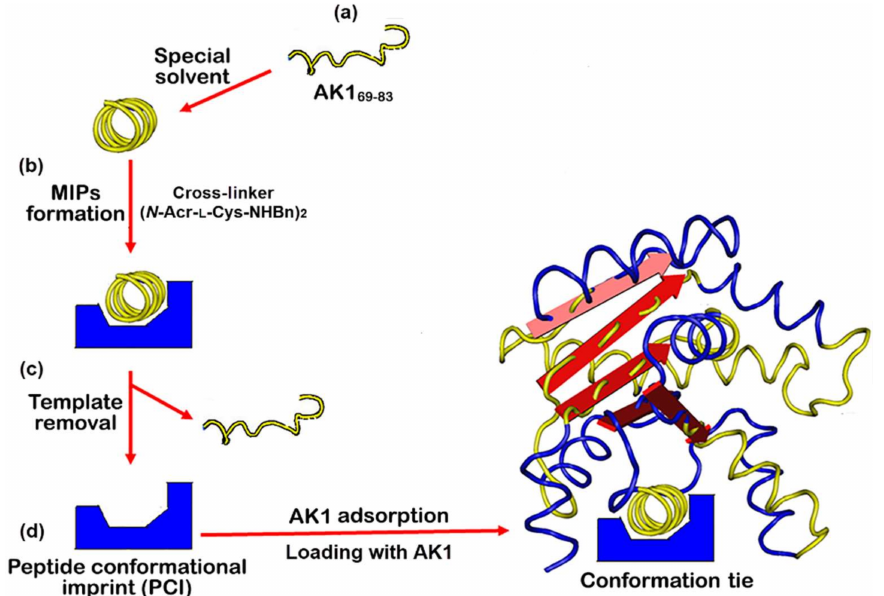
Figure 3. The fabrication of a peptide conformational imprint for adenylate kinase 1 (AK1). ( a ) Prepa- ration of the AK1 69-83 as a template. ( b ) Fabrication of hinge-mediated molecularly imprinted polymers (MIPs) in a special solvent using cross-linker ( N -Acr-L-Cys-NHBn) 2 and the template. ( c ) After template removal, the peptide conformational imprint (PCI) was complementary to the tem- plate peptide. ( d ) PCI loading with AK1. The recognition of an AK1 and its characteristic fragments as acting as an accelerator or an inhibitor is a conformation tie. Table 1. The chemical properties of peptides and their affinity toward